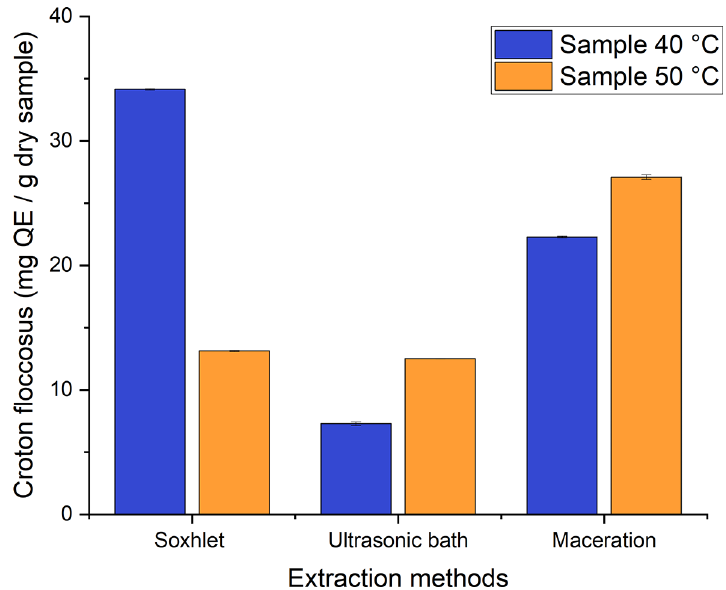
Figure 12. Total flavonoid content of the different ethanolic extracts of Croton